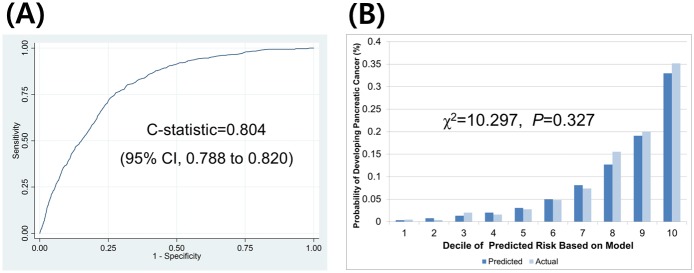
Discrimination and calibration ability of the pancreatic cancer prediction model in women as assessed in an external validation set (n = 627,629, events = 576).(A) discrimination ability and (B) calibration ability.